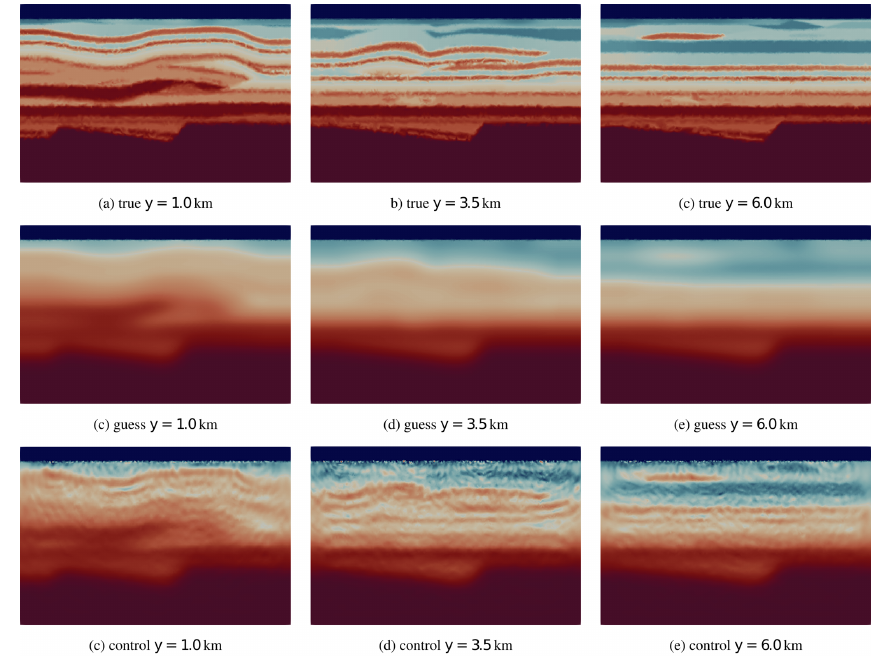
Figure 20. Same as Fig. 19 but for the y